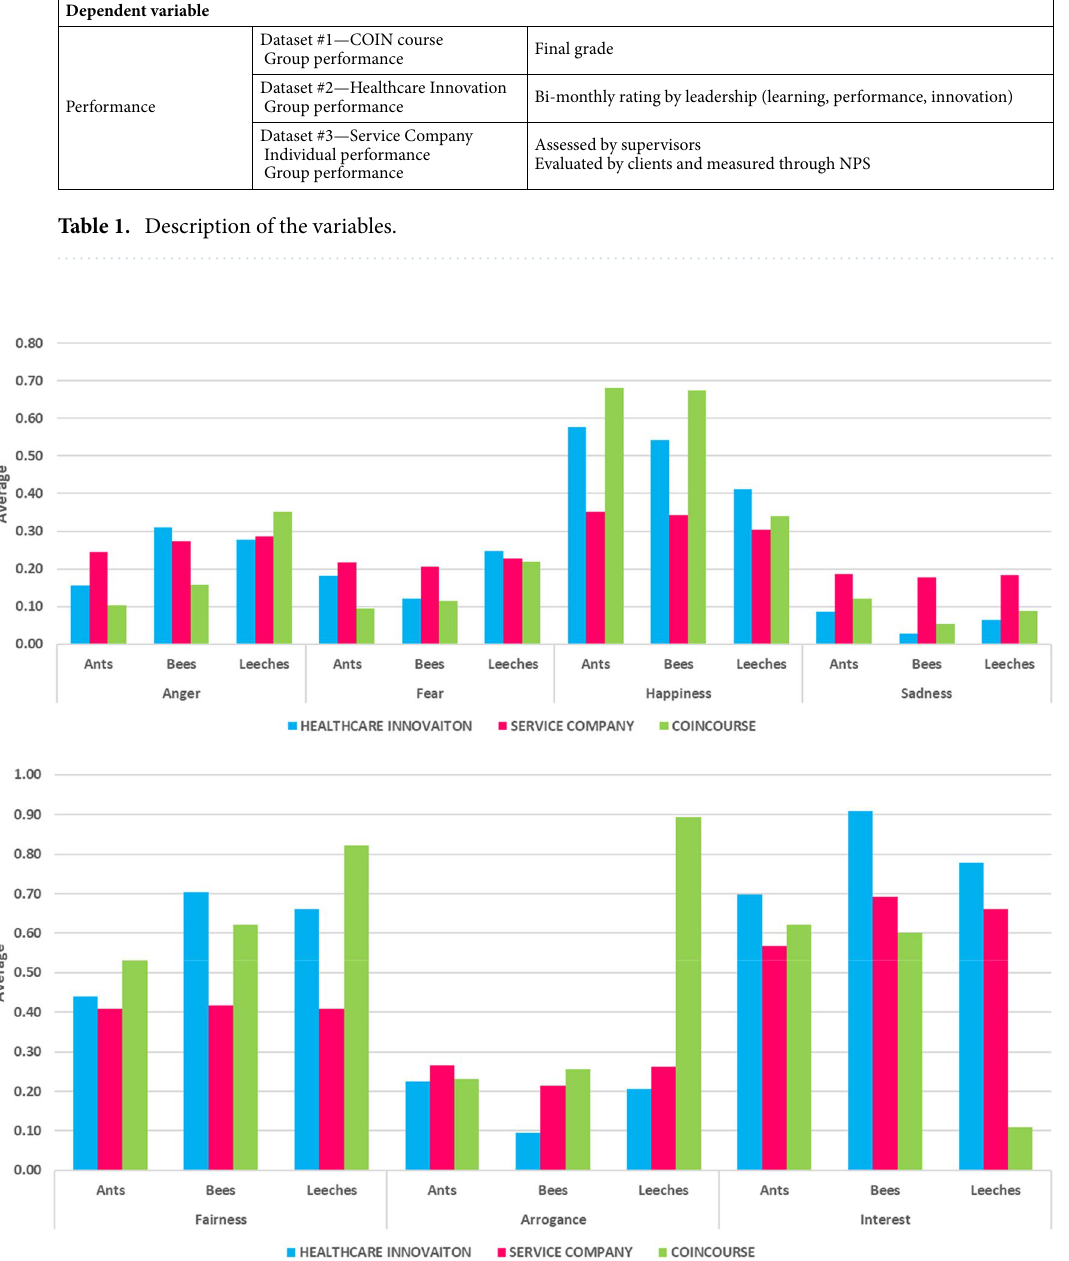
Figure 1. Average emotional and behavioral scores of ants, leeches and